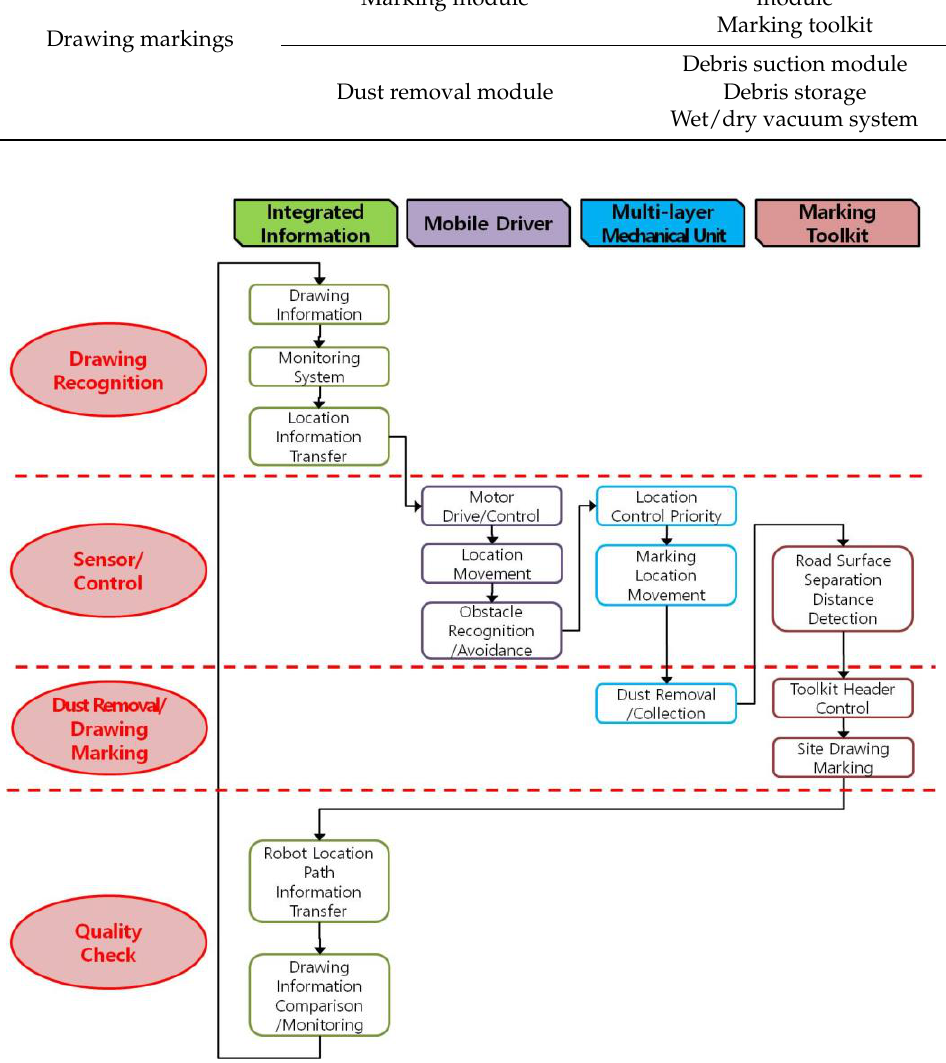
Figure 16. Integrated, automated layout-printing robot concept and process.